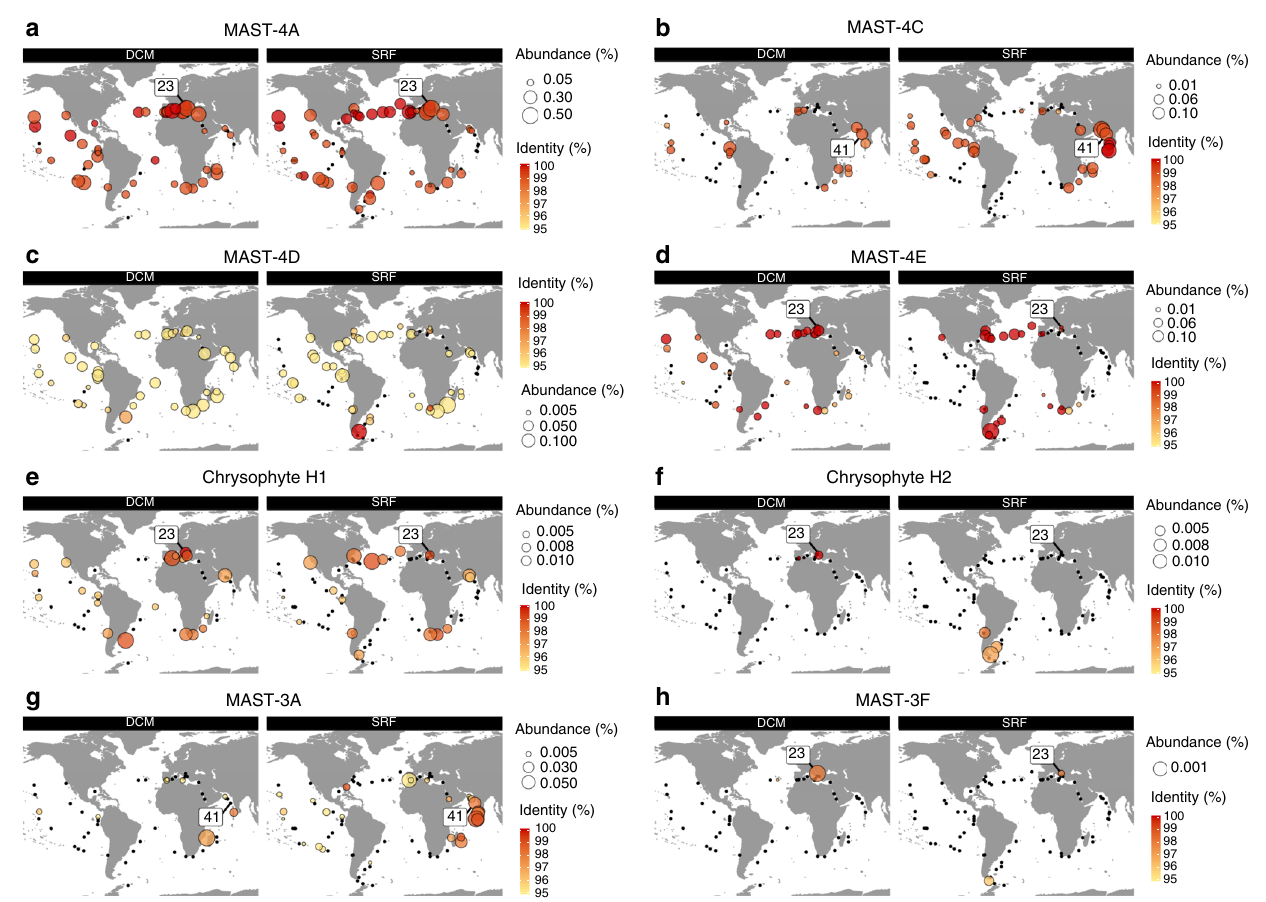
Fig. 3 Biogeographic distribution of the SAG lineages based on metagenome read recruitment with separation between deep chlorophyll maximum and subsurface. Global maps showing the presence of the SAG lineages based on metagenomics read mapping at each Tara Oceans station either as a black dot (no signal detected) or as a circle whose diameter indicates the species relative abundance. Abundance in samples from deep chlorophyll maximum (DCM, left panel) often differs from surface samples (SRF, right panel): only MAST-4A shows the same pattern in DCM and SRF samples ( a ). The color inside each circle provides the median percentage similarity of the reads to the reference. The station from where the SAG originates is indicated by its number. a MAST-4A; b MAST-4C; c MAST-4D; d MAST-4E; e Chrysophyte H1; f Chrysophyte H2; g MAST-3A; and h